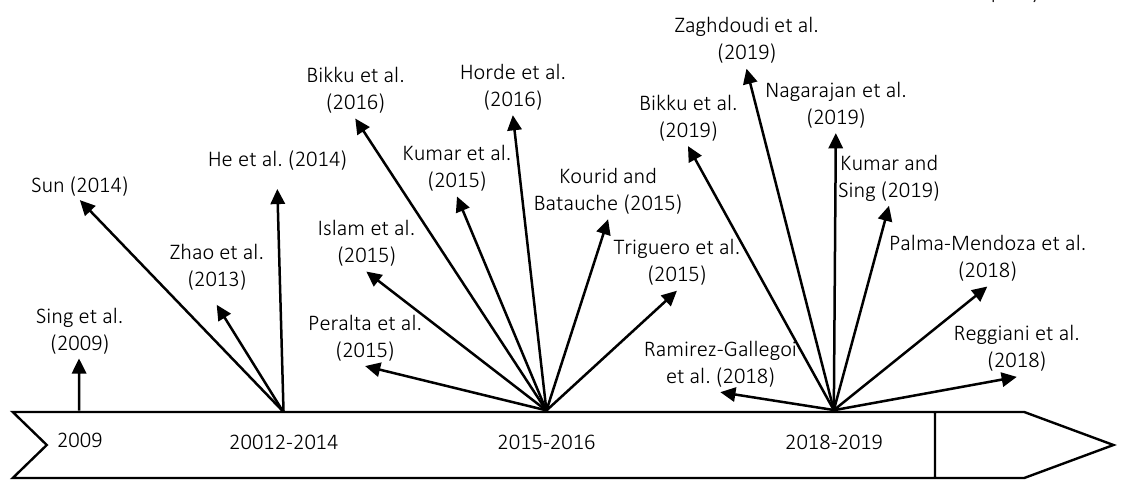
Figure 7. Feature selections techniques based on